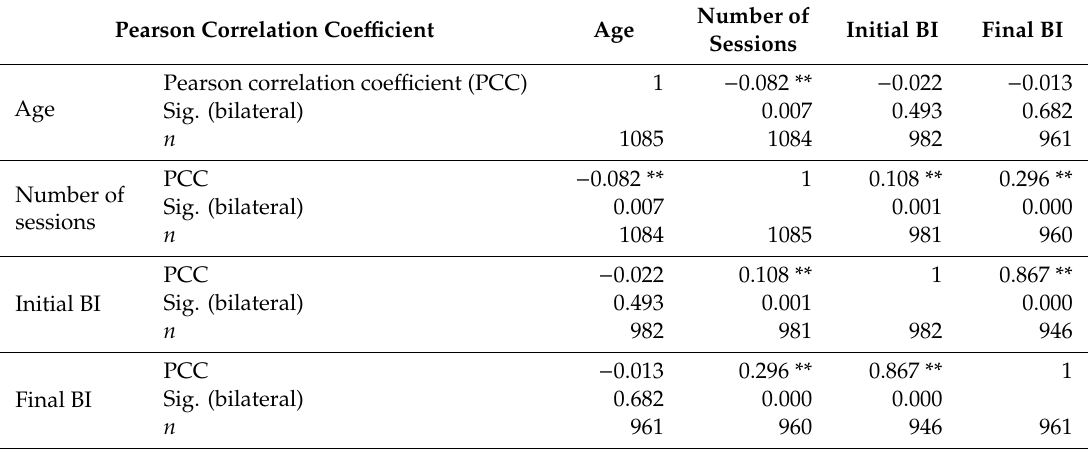
Table 5. Correlations for age, number of sessions, and initial and final Barthel